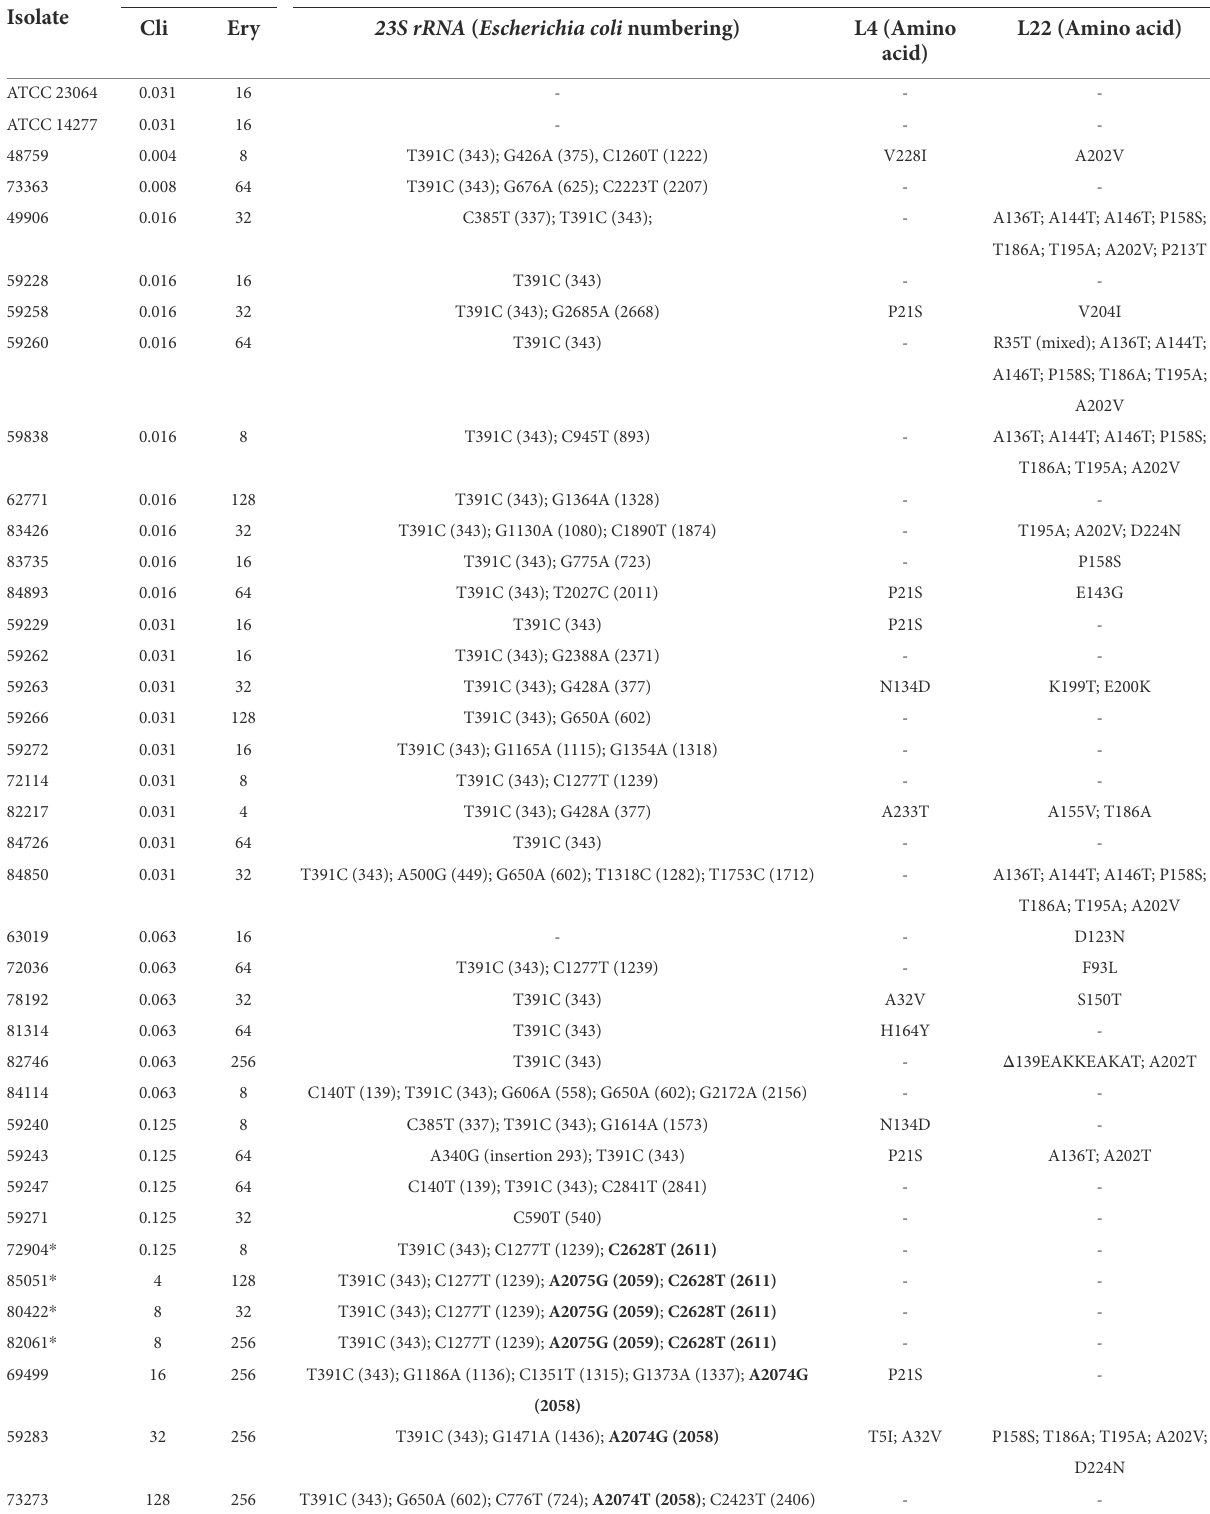
TABLE 2 Clindamycin MIC and alterations in 23S rRNA gene and ribosomal